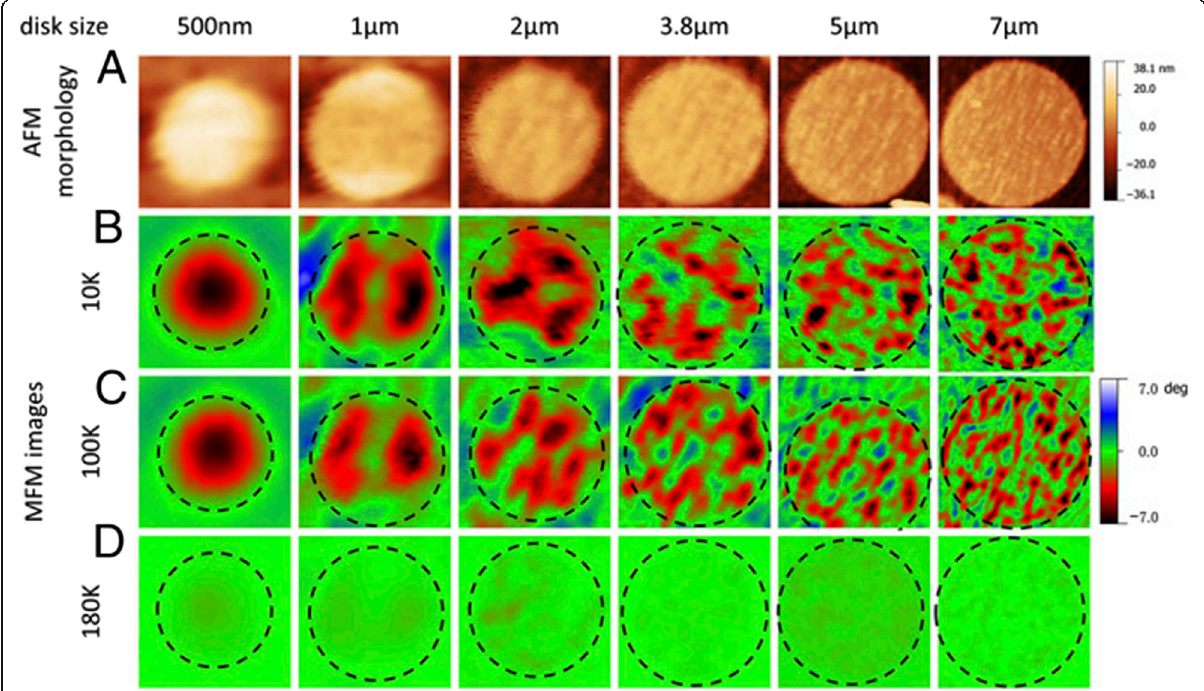
Fig. 33 a AFM images of the La 0.325 Pr 0.3 Ca 0.375 MnO 3 (LPCMO) disks with diameter sizes of 500 nm, 1 μ m, 2 μ m, 3.8 μ m, 5 μ m, and 7 μ m in diameter. b – d MFM images of the LPCMO disks under external magnetic field of 1 T (external magnetic field direction is pointing perpendicularly to the sample surface plane) taken at 10 K ( b ), 100 K ( c ), and 180 K ( d ). The negative value in MFM image indicates attractive force and positive value indicates repulsive force. Reproduced with permission of